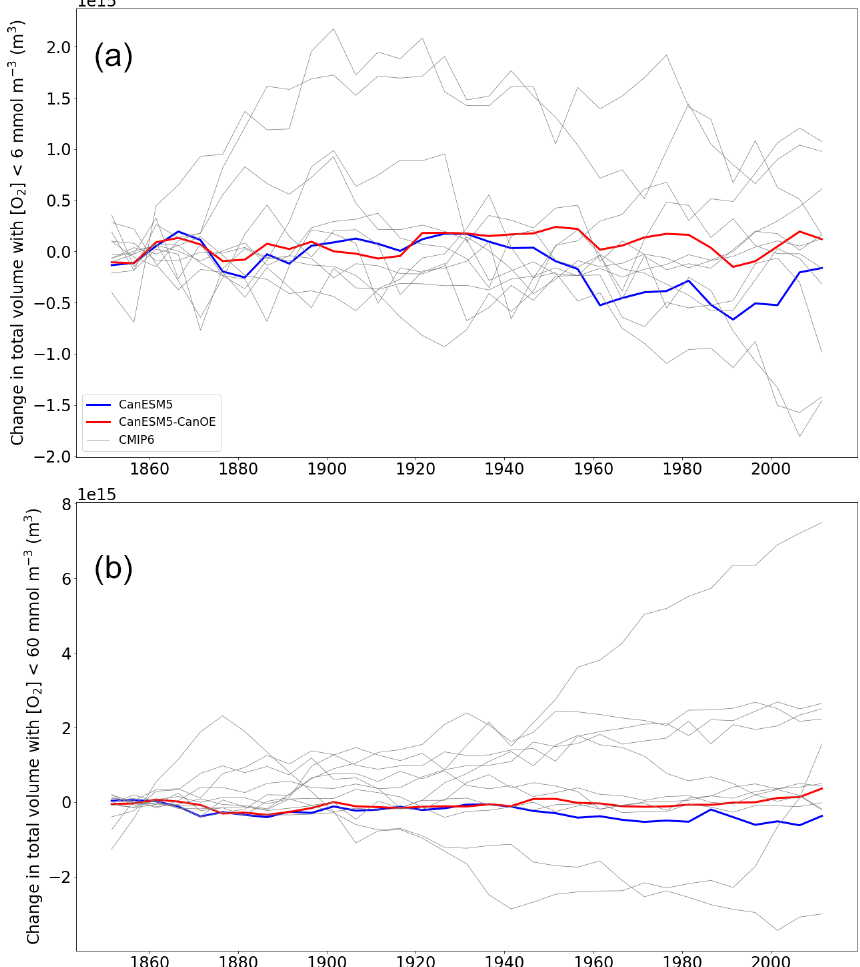
Figure 22. (a) Change in total ocean volume with oxygen (O 2 ) concentration less than (a) 6mmolm − 3 and (b) 60mmolm − 3 over the course of the historical experiment (1850–2014), normalized to the 1850–1870 mean. Data are shown as successive 5-year means. The thick red line represents CanESM5-CanOE, thick blue line CanESM5, and thin grey lines other CMIP6